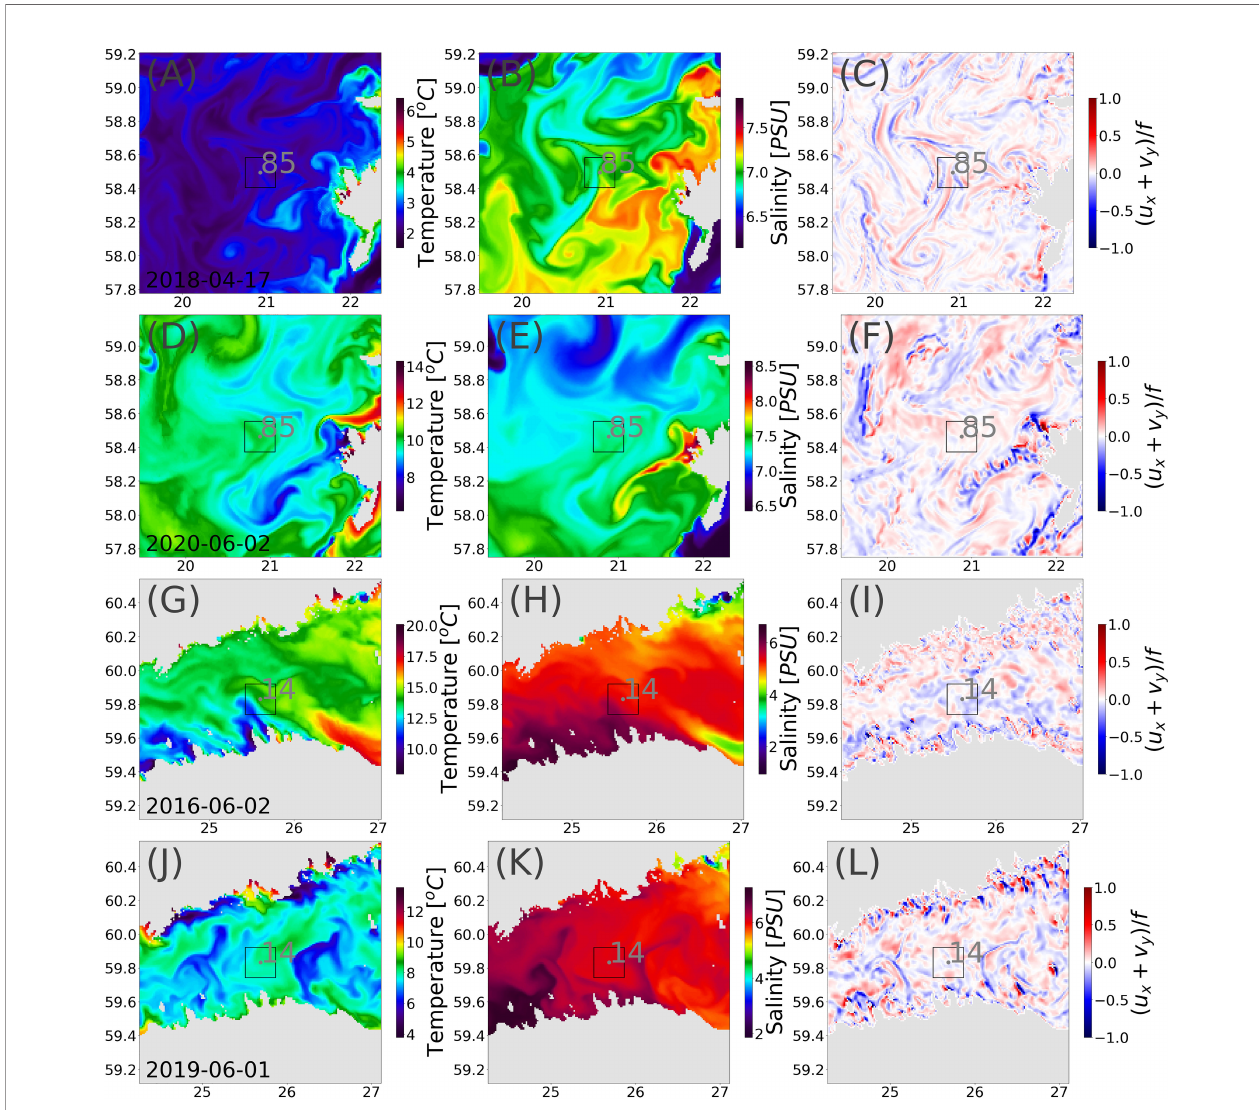
FIGURE 8 | Snapshots of surface temperature (A, D, G, J) , surface salinity (B, E, H, K) , and current fi eld divergence, u x +v y / f , in the surface layers (C, F, I, L) during the highest and lowest measured concentration of MPs at selected stations. The gray box indicates the location around measurement location with 10-km